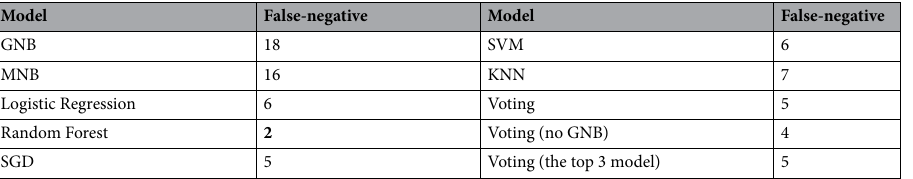
Table 5. False-negative numbers for all classifiers. GNB, Gaussian naïve Bayes; MNB, multinomial naïve Bayes; SGD, stochastic gradient descent; SVM, support vector machine; KNN, K-nearest neighbor.